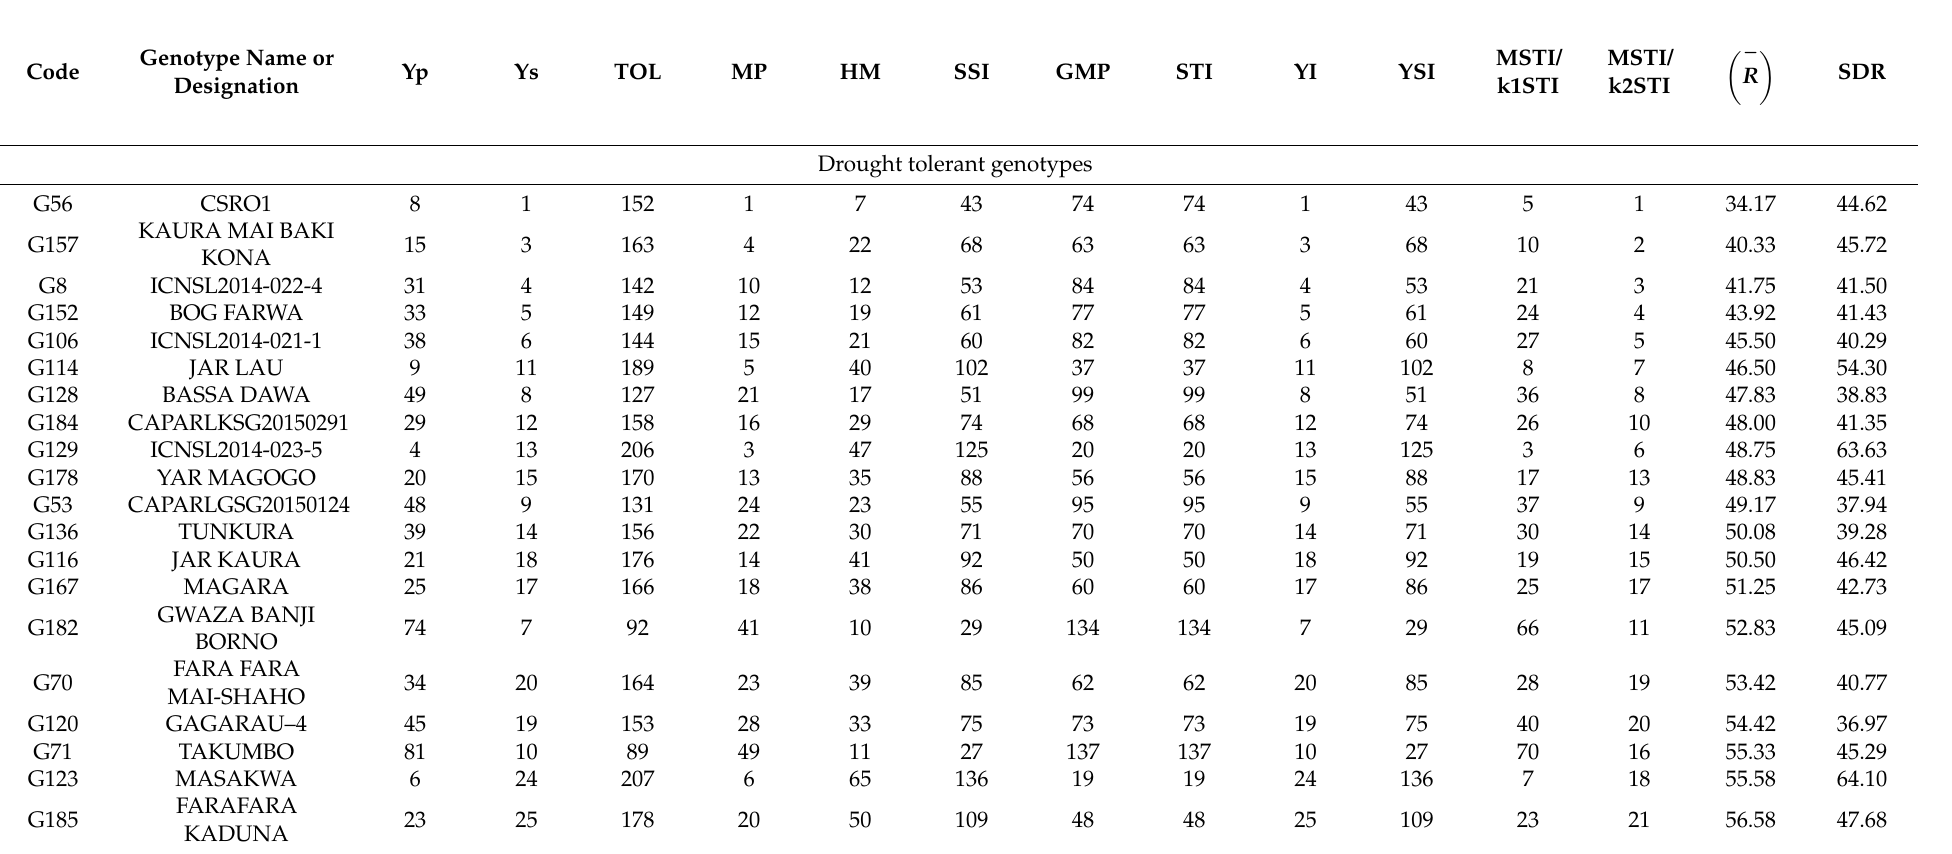
(cid:0) (cid:1) R Table 4. Rank, rank mean and standard deviation of ranks (SDR) of drought tolerance indices of the sorghum genotypes in